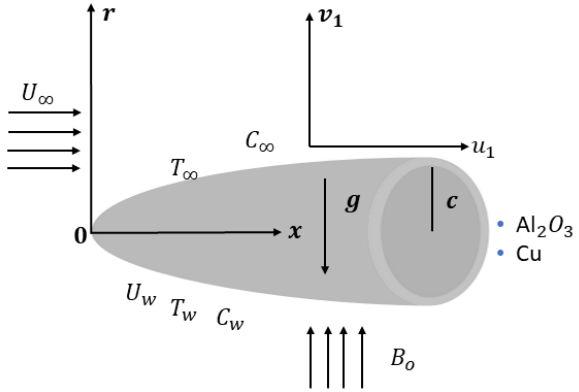
Figure 1. Physical